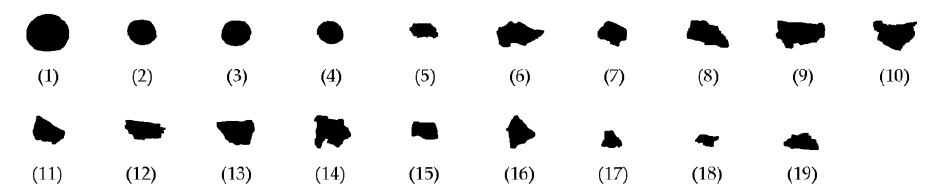
Figure 11. RRSB distribution of polypropylene/ethylene-propylene-diene-monomer (PP/EPDM) scraps.